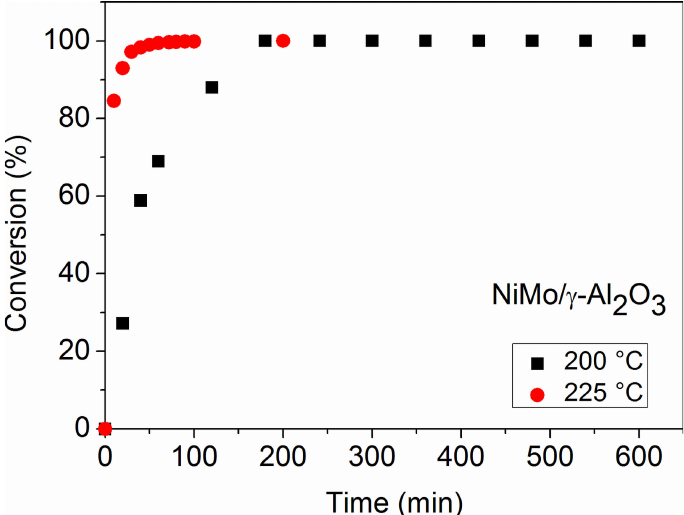
Figure 3. Conversion of mucic acid during HDO over sulphided NiMo/ γ -Al 2 O 3 catalyst at 200 and 225 ◦